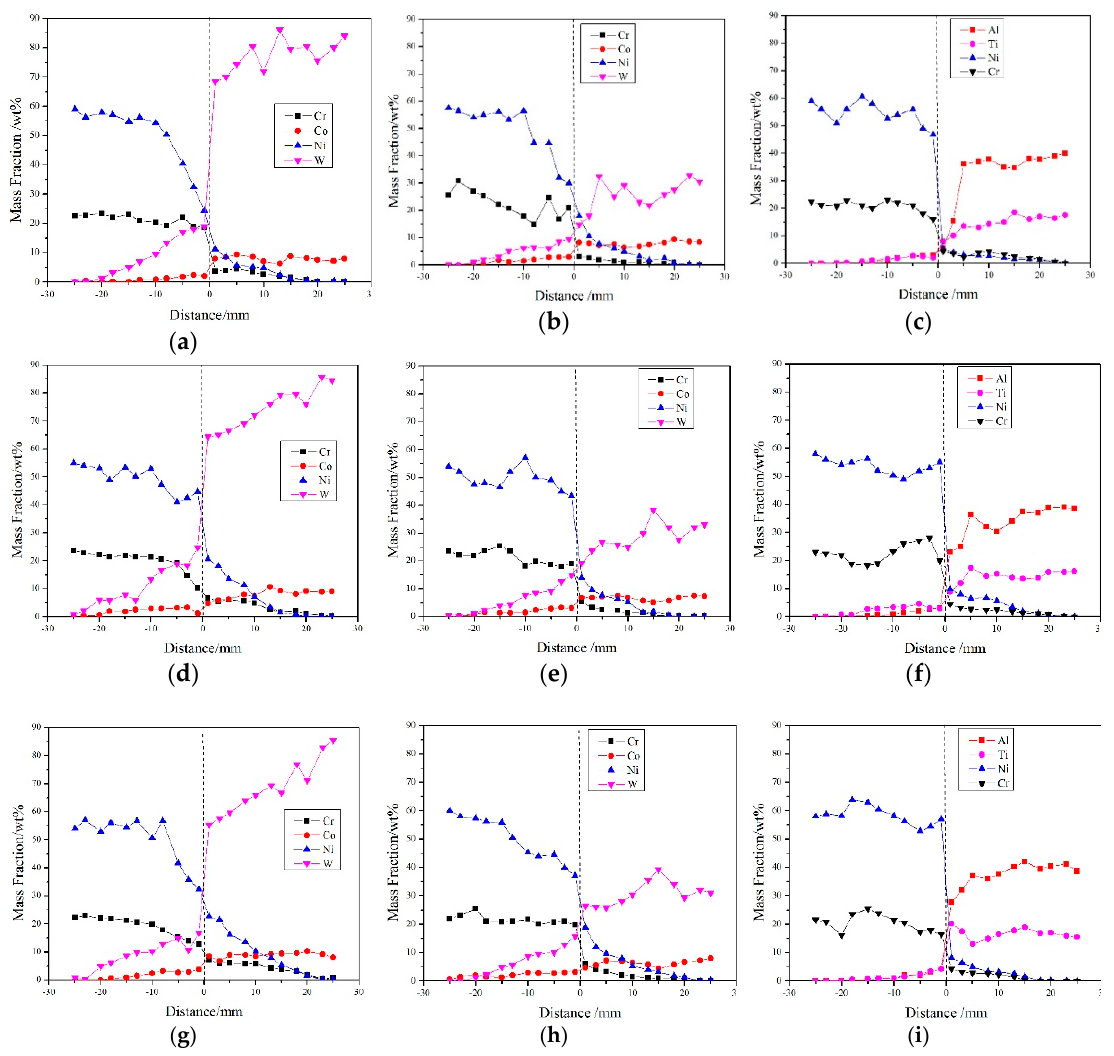
Figure 11. Element diffusion curves between tool material and Inconel 625. ( a ) WC/Co (973 K), ( b ) coated carbide (973 K), ( c ) ceramic (973 K), ( d ) WC/Co (1173 K), ( e ) coated carbide (1173 K), ( f ) ceramic (1173 K), ( g ) WC/Co (1273 K), ( h ) coated carbide (1273 K), and ( i ) ceramic (1273 K). (Error bars are smaller than the symbols.) Table 5. Diffusion coefficients of the main elements of WC/Co and Inconel 625 (90 min). Diffusion Temperature